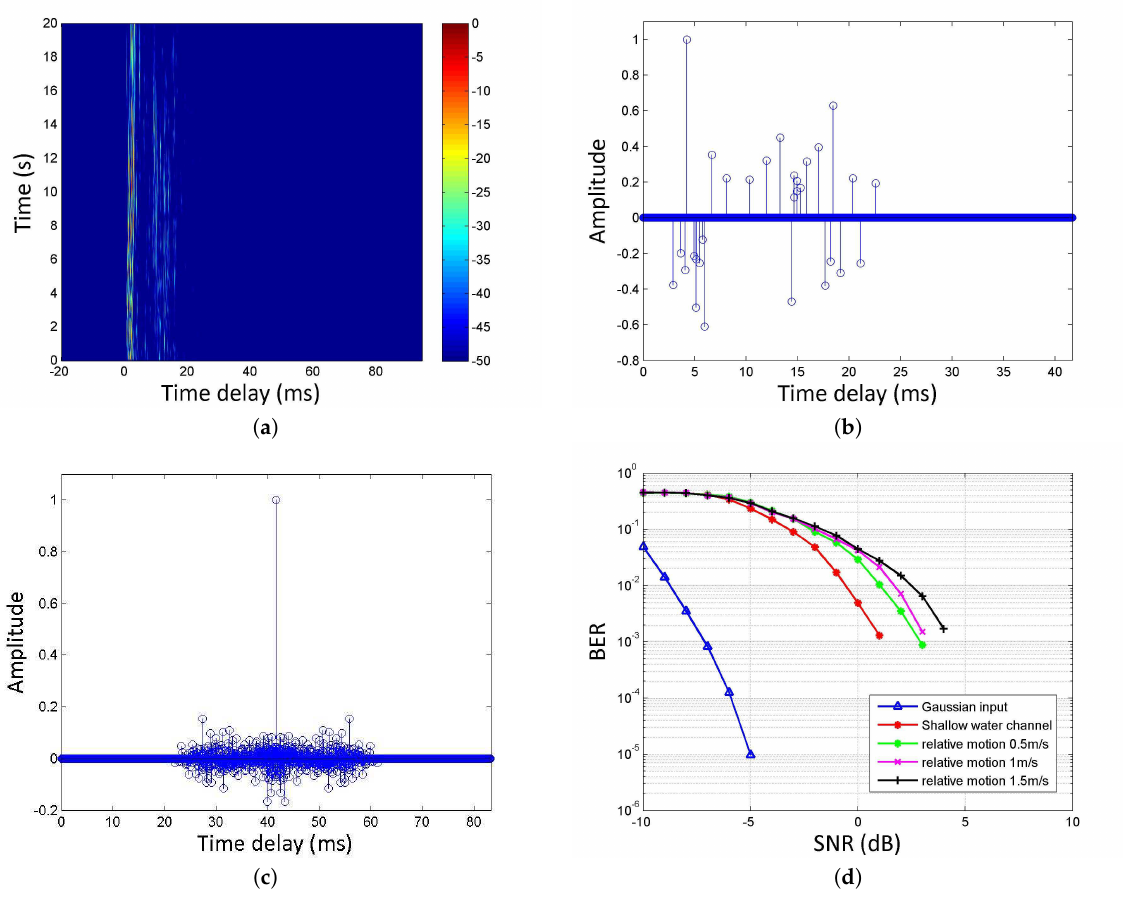
Figure 12. Algorithm simulation conditions and results; ( a ) Time-varying channel impulse response; ( b ) Channel impulse response estimated by the MP method using a dolphin whistle; ( c ) Virtual channel after virtual time reversal mirror (VTRM) by using the estimated channel impulse response; ( d ) bit error rate (BER) of demodulation